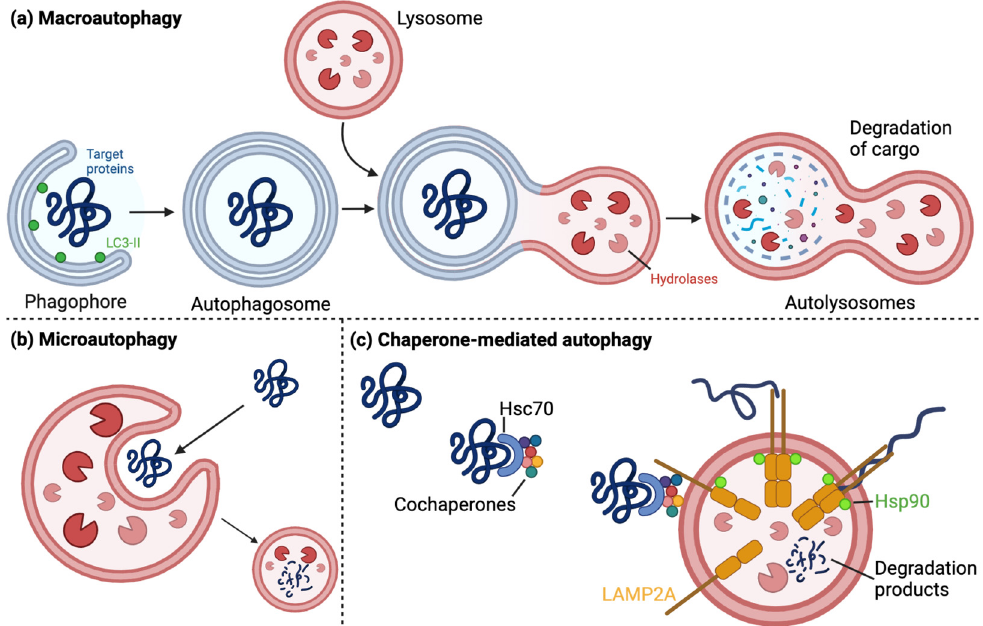
Figure 1. Visual representation of the autophagy–lysosomal pathway. ( a ) Macroautophagy is the engulfment of target proteins by a phagophore through the interaction between LC3-II on the phagophore and the target. The resulting double-membrane autophagosome can then fuse with hydrolase-containing lysosomes, resulting in the lysosomal degradation of the target proteins. ( b ) Microautophagy is the direct endocytosis of target proteins by lysosomes, which results in target degradation. ( c ) Chaperone-mediated autophagy involves several chaperones such as Hsc70, which facilitate the binding of target proteins to lysosomal-associated proteins such as LAMP2A. Subsequent steps include multimerization of LAMP2A proteins, which is stabilized by lysosomal membrane-associated Hsp90. This results in the unfolding of the target protein, internalization into the lysosome, and its subsequent degradation. Created using www.BioRender.com (accessed on 10 December 2022).